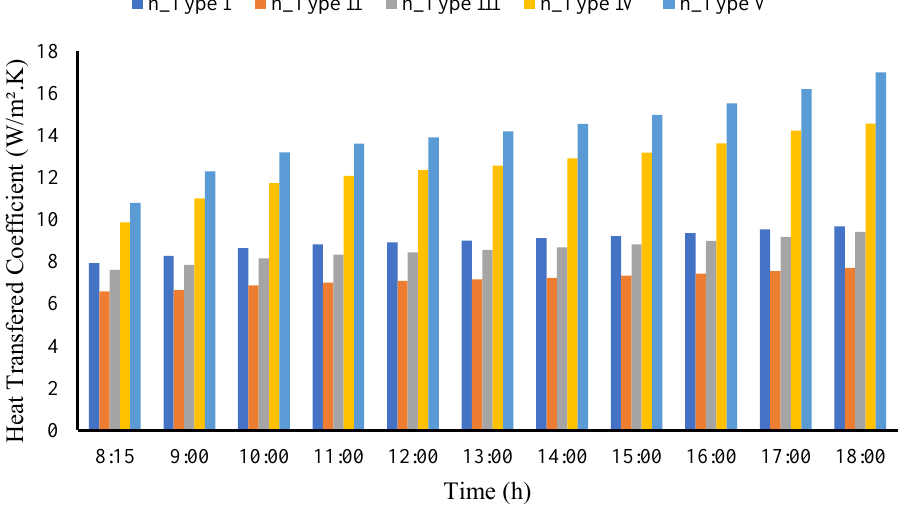
to 1056.4 W/m 2 , with maximum values of 9.67, 7.7, 9.41, 14.56, and 17 (W/m 2 . K).